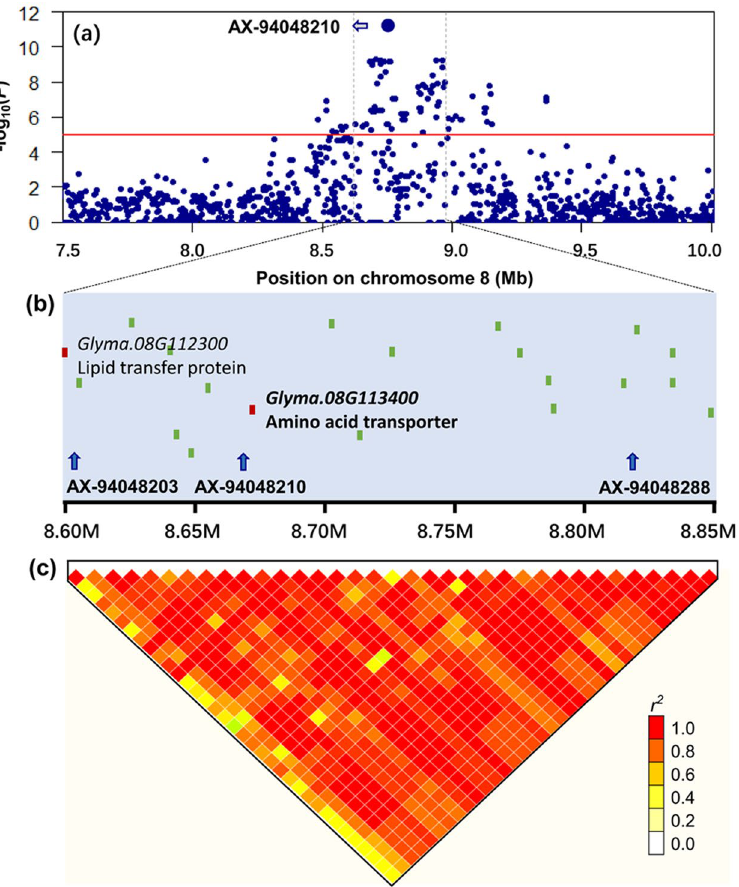
Figure 3. Associations, genomic locations and the pattern of pairwise LD of SNPs associated with water- soluble protein content (WSPC) on chromosome 8. ( a ) A 2.5-Mb region of the major-effect quantitative trait loci ( GqWSPC8 ) harboring the peak SNP, AX-94048210 on chromosome 8. The most significantly associated SNP is shown with a big blue dot. Red horizontal lines depict the Bonferroni-adjusted significance threshold ( P < 4.95 × 10 − 6 ). The x axis shows the genomic position, and the y axis shows the significance expressed as − log 10 P value. ( b ) Soybean genome region around the SNP marker, AX-94048210 on chromosome 8, whose position is indicated by a vertical gray dashed line (0.25-Mb) on the top panel. ( c ) The extent of linkage disequilibrium (LD) in the regions based on pairwise r 2 values. The r 2 values are indicated using the color intensity index. Heatmap showing LD between each pair of markers that passed the Bonferonni threshold in